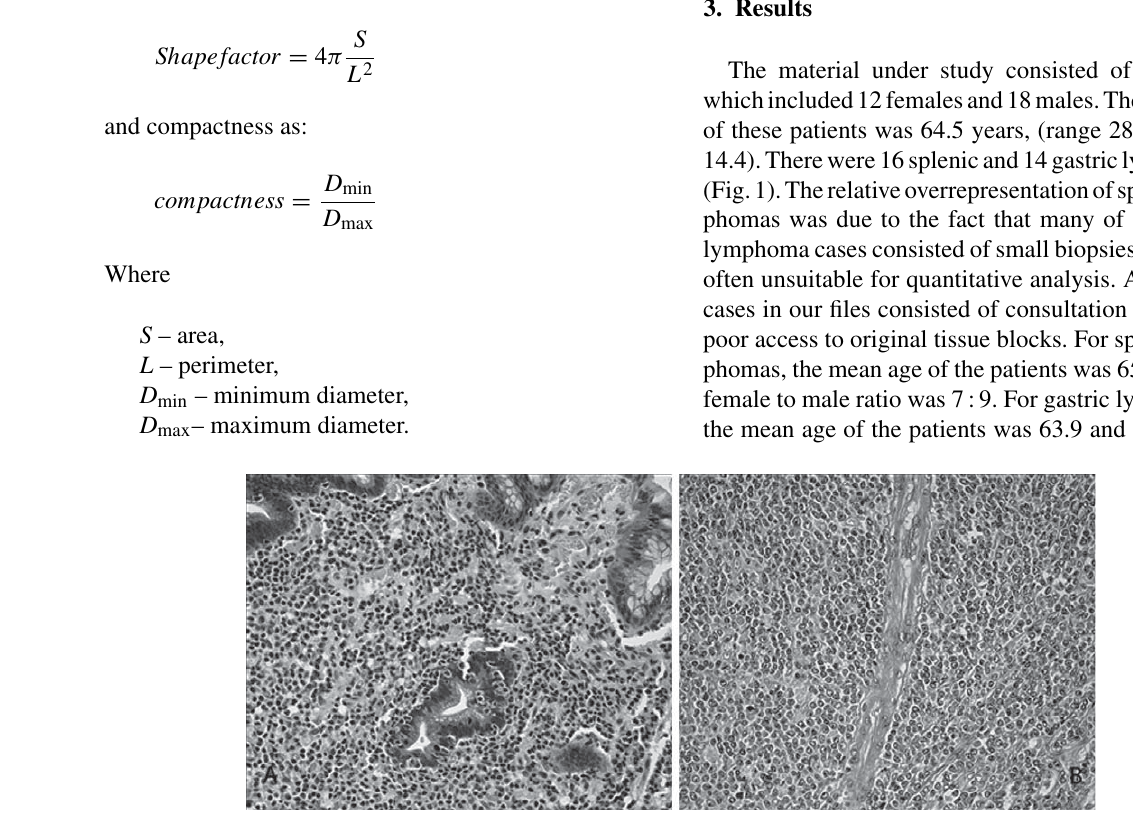
Fig. 1. Examples of gastric (A) and splenic (B) marginal zone lymphoma. Hematoxylin – eosin, original magnification 200 ×